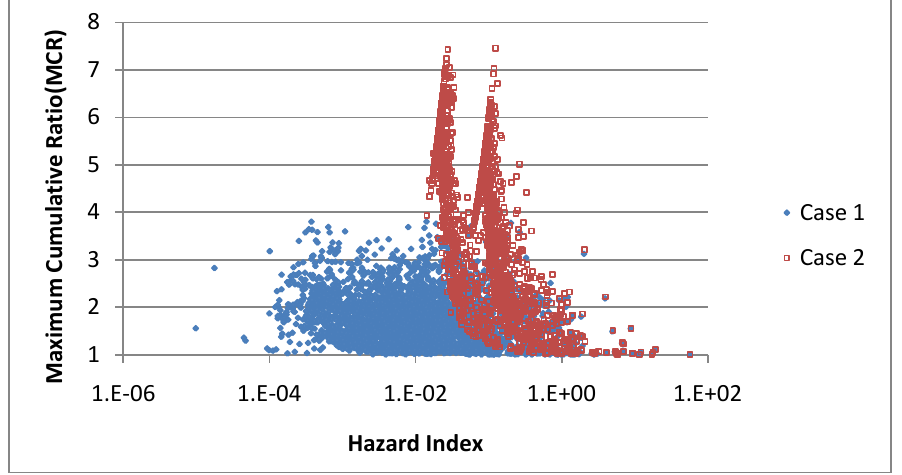
Figure 6. Plot of MCR and HI values for all samples. HI and MCR are negatively correlated, Kendall’s tau-b values of –0.16 (p < 0.001) for Case 1 and values of –0.18 (p < 0.0001) for Case